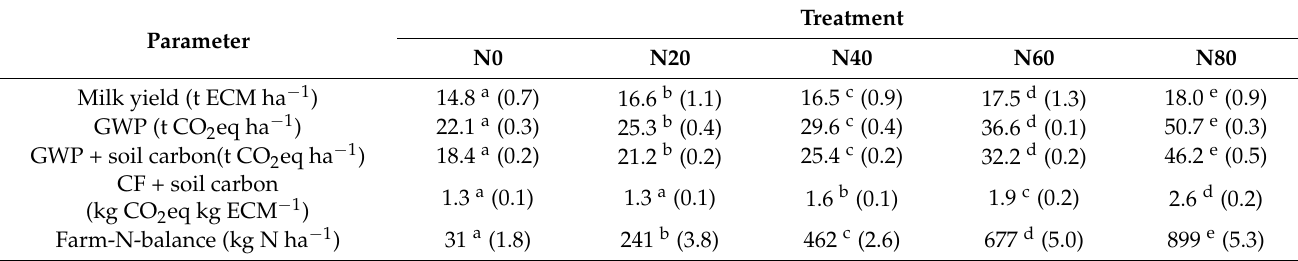
Table 3. The potential average milk yields, GWP, CF and N-balance for the various treatments (N0, N20, N40, N60 and N80) over the three years. SEM are shown in